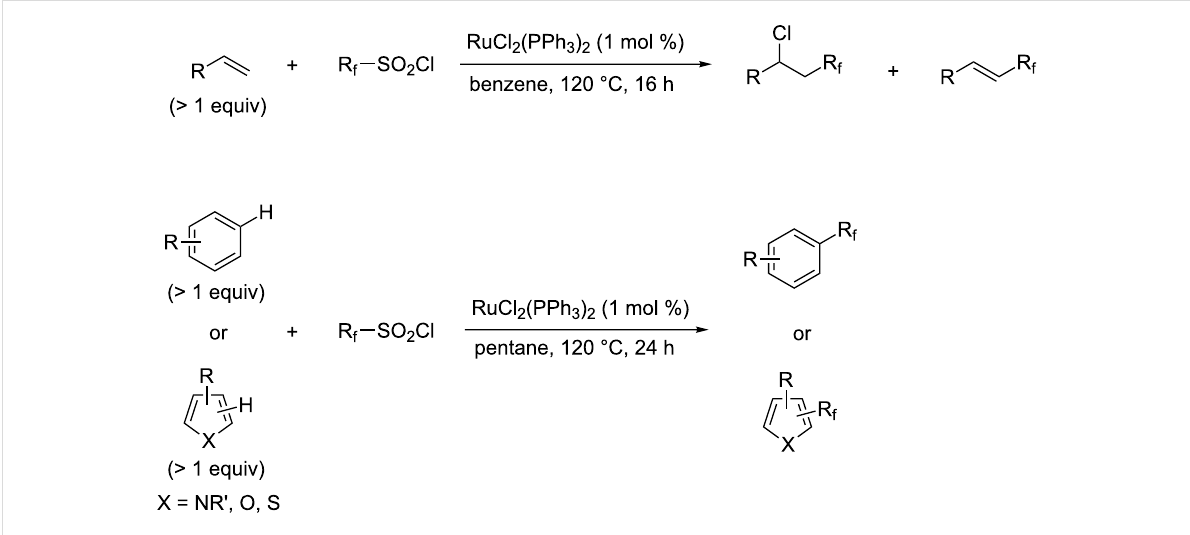
in the case of thiophenes, where 2-perfluoroalkylated products were obtained, as long as at least one of the positions α to sulfur was unsubstituted; otherwise β -functionalization occurred. The same comment is applicable to pyrroles bearing a small group on nitrogen, which gave the 2-perfluoroalkylated compound as the major product. For instance, N -TMS-pyrrole afforded a global yield of 78% of the 2-functionalized product as a mix- ture of the silylated and hydrolized compounds. On the other hand, the reaction of N -triisopropylsilylpyrrole favoured the 3-perfluoroalkylated product over its 2-isomer, due to the steric bulk of the TIPS group. Considering the mechanism of these reactions, the authors propose a radical pathway, and